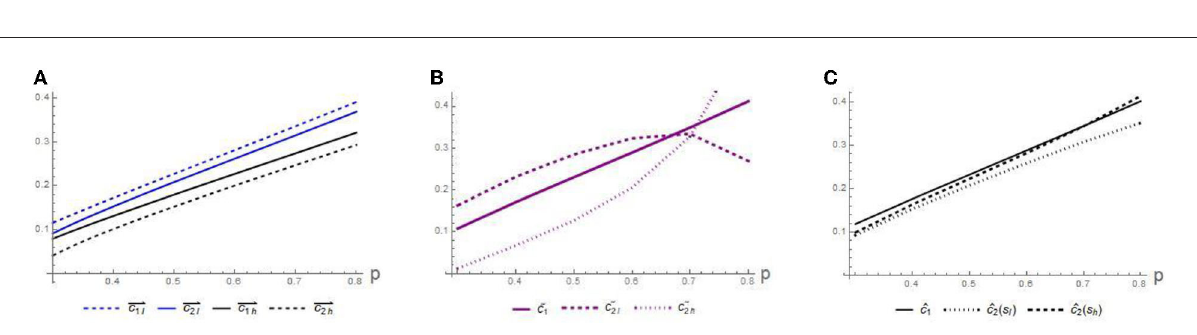
FIGURE5 Impact of signing fee on the disclosure intensity c in scenario: (A) separating-separating, (B) pooling-separating, and (C)